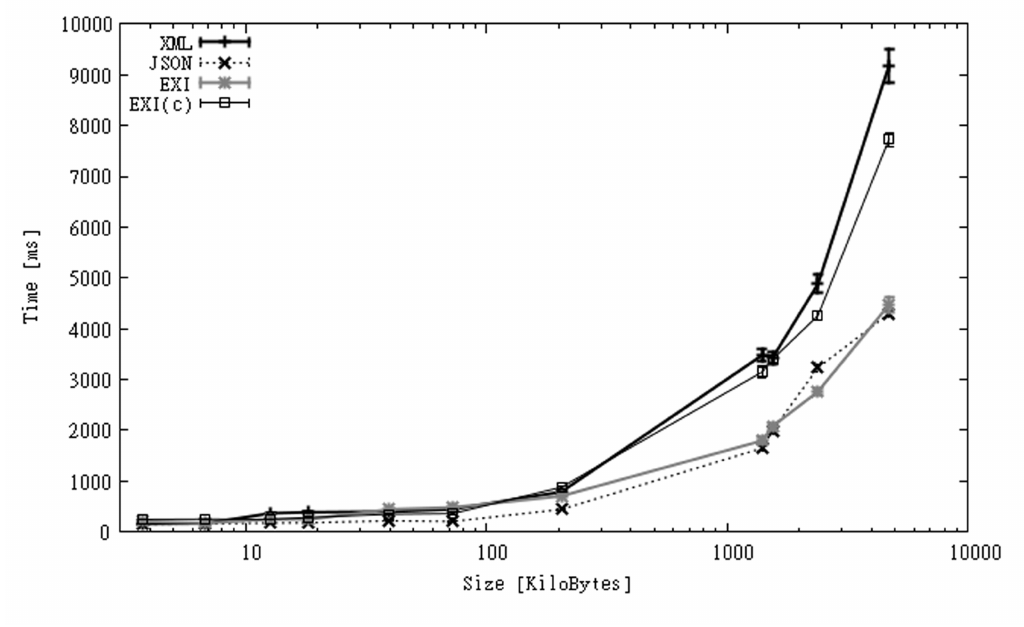
Figure 4. Processing times over a Wi-Fi connection for SGS2 smartphone (CAPS